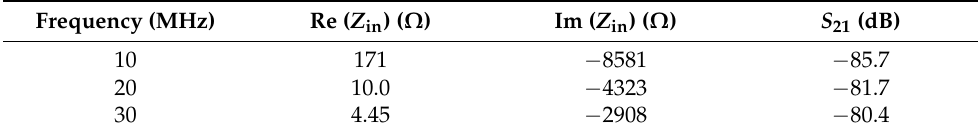
Figure 8. Electric field distributions around and inside the head model with the single-electrode transceiver at ( a ) 10, ( b ) 20, and ( c ) 30 MHz. Table 4. Simulation results with the single-electrode transceiver.